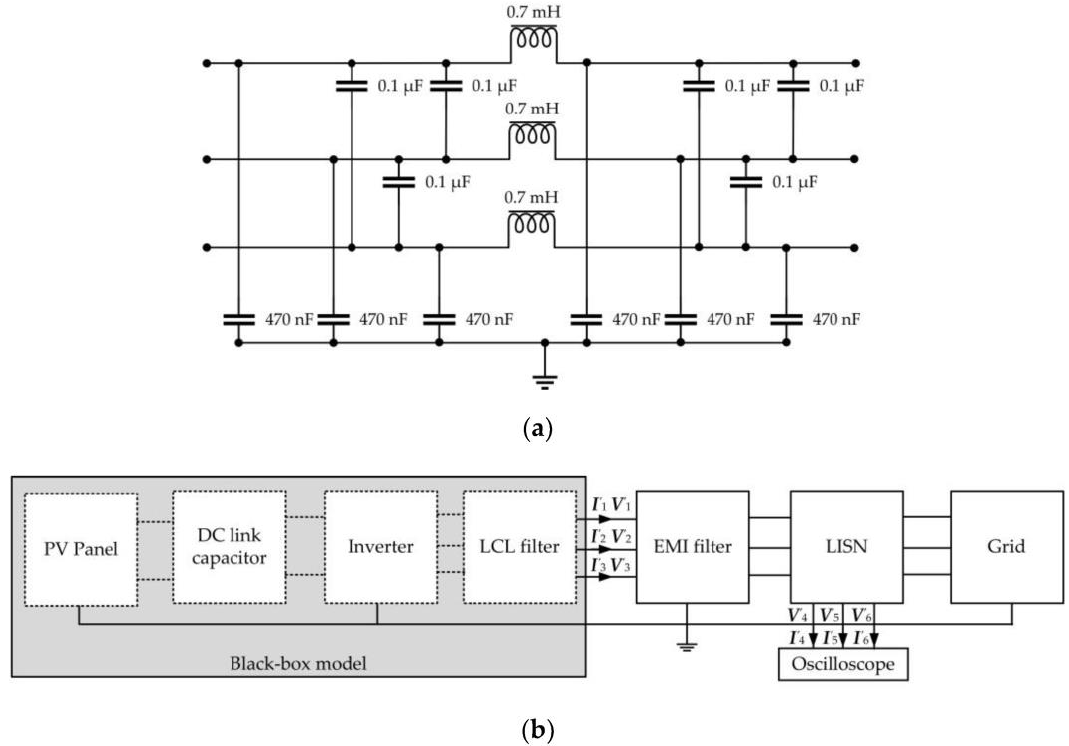
Figure 9. Validation of the black-box model: an additional EMI filter ( a ) is included in the measurement setup ( b ) to modify the working conditions of the converter.